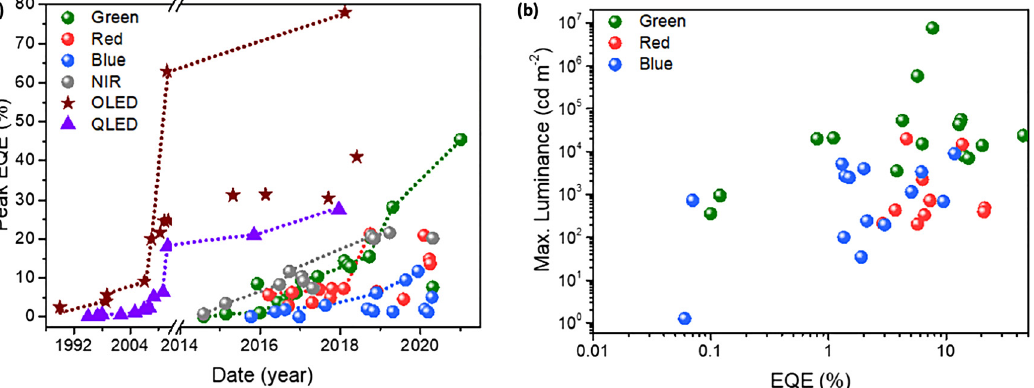
Figure 1: (a) Yearly peak external quantum efficiency (EQE) growth and (b) maximum luminance as a function of EQE for red, green and blue perovskite-basedlight-emittingdiodes(PeLEDs)andaswellasthoseofcurrentlightingtechnologies(OLEDandQLED).Thedataarecollected from previous studies [3 – 93] and are tabulated in Table